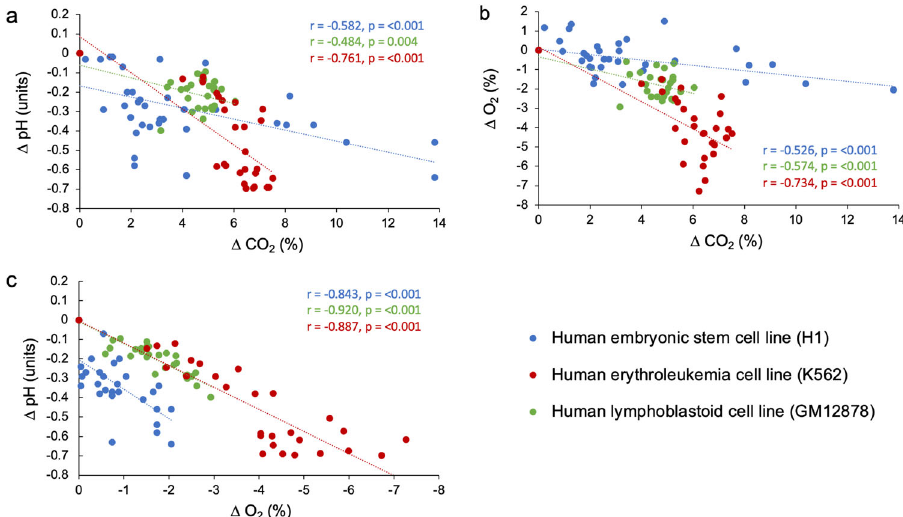
Fig. 5 Relationships between changes in dissolved gases and medium acidi fi cation in cultures of H1 hESC, K562, and GM12878. Delta ( Δ ) values for the environmental variables (pH, dO 2 , and dCO 2 ) represent the mean difference between levels measured at 8 h intervals minus measurements taken at time zero. a The relationship between reductions in pH and increases in dCO 2 in cell culture media. b The relationship between reductions in dO 2 and increases in dCO 2 in cell culture media. c The relationship between reductions in pH and dO 2 in cell culture media. Data points represent individual measurements taken from three culture fl asks per cell line. Insets show the Pearson correlation coef fi cient ( r ) and p -value for each correlation model (cf. Supplementary Table S2 for full statistical results).